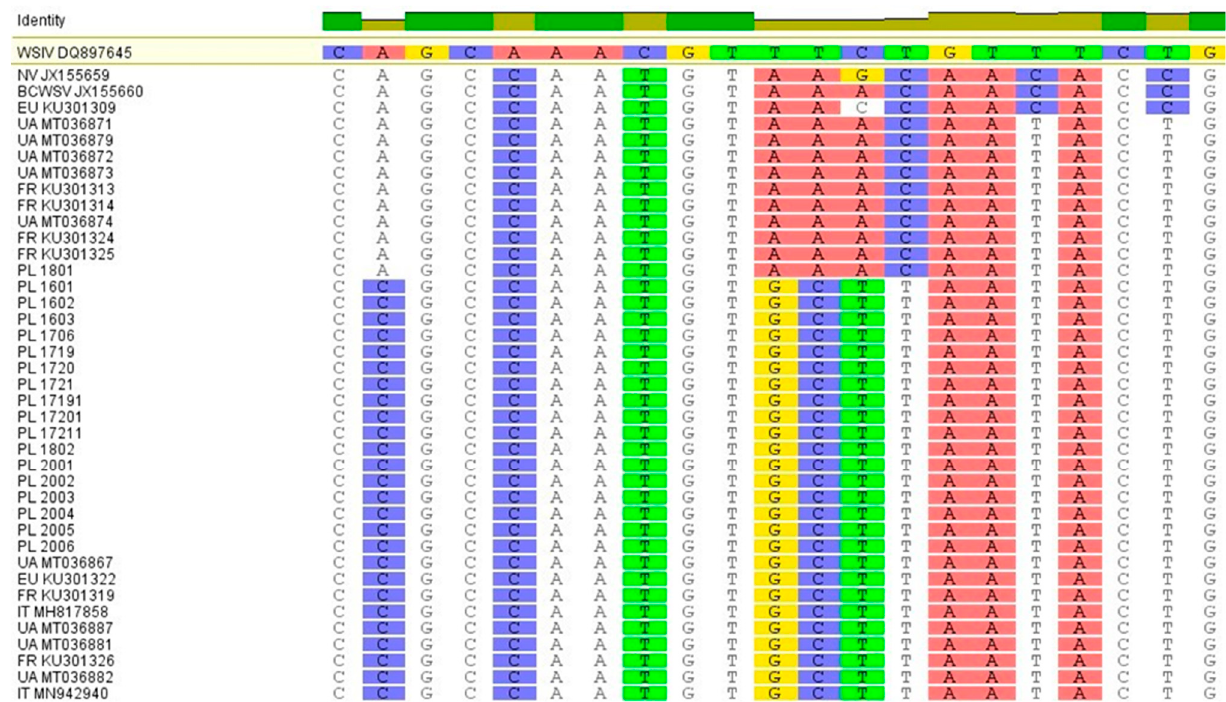
Figure 4. Aligned Polish sequences with highlighted motifs characteristic for American strains ( var1 -AAACAATA) and European variant ( var2 -GCTTAATA) of mimivirus.